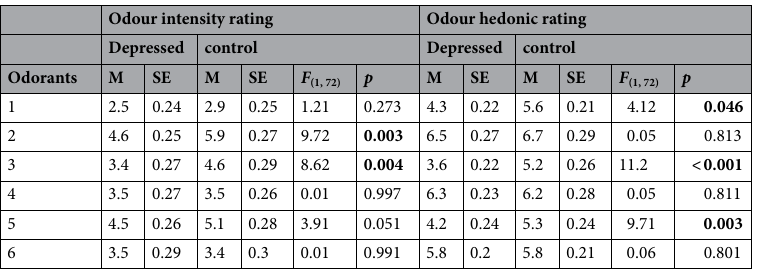
Table 4. Mean (M) and standard error (SE) of intensity and hedonic ratings from the patient and control groups for the six testing odorants. Significant p-values derived from the post-hoc tests are in bold (p <